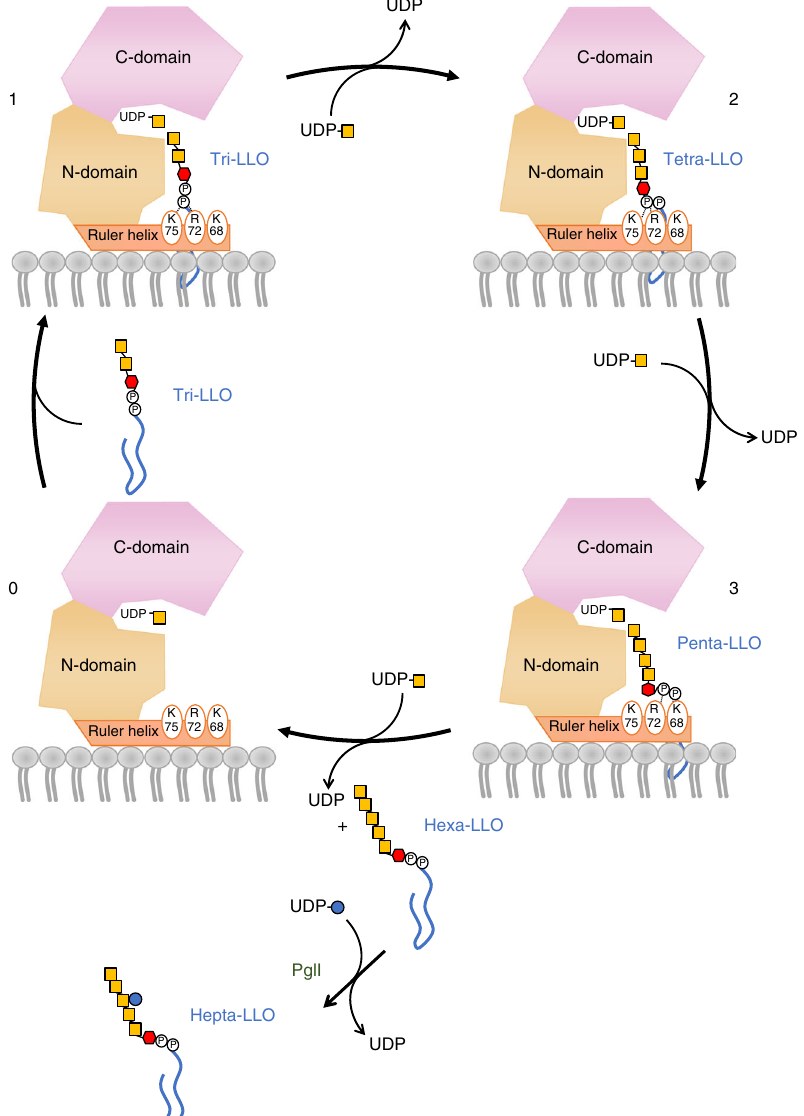
Fig. 5 Glycan counting mechanism during PglH reaction. PglH is shown schematically, with N-terminal and C-terminal domains shaded yellow and pink, respectively, and labeled. The ruler helix is shaded orange, and the three residues relevant to the counting mechanism are indicated. Phospholipids from lea fl et of the lipid bilayer are depicted in gray. The polyprenyl tail of the LLO is depicted as a blue, curved line, phosphate moieties as a circled P, and the saccharide symbols are as in Fig. 1. State 0 corresponds to UDP-GalNAc-bound PglH as observed in our crystal structure. State 1 represents a ternary complex upon binding of Und-PP-Bac-GalNAc 2 (tri-LLO), with the pyrophosphate group of tri-LLO interacting with the side chains of residues K75 and R72 as observed in the two crystal structures with LLO bound. Following transfer of the fi rst GalNAc, the product Und-PP-Bac-GalNAc 3 (Tetra-LLO) is predicted to move along the ruler helix, where the pyrophosphate moiety of the LLO will be coordinated mainly by the side chains of R72 (state 2). After the second transfer reaction, the product, Und-PP-Bac-GalNAc 4 (Penta-LLO) is predicted to move along the ruler helix once more, where the pyrophosphate moiety of the LLO will be coordinated mainly by K68 (state 3). The shown interactions of the LLO with the ruler helix are inferred from functional experiments. Each transfer reaction involves an exchange of UDP for a UDP-GalNAc. Once the product Und-PP-Bac-GalNAc 5 (Hexa-LLO) is released from PglH, it is processed by PglI, which adds a glucose moiety to the third